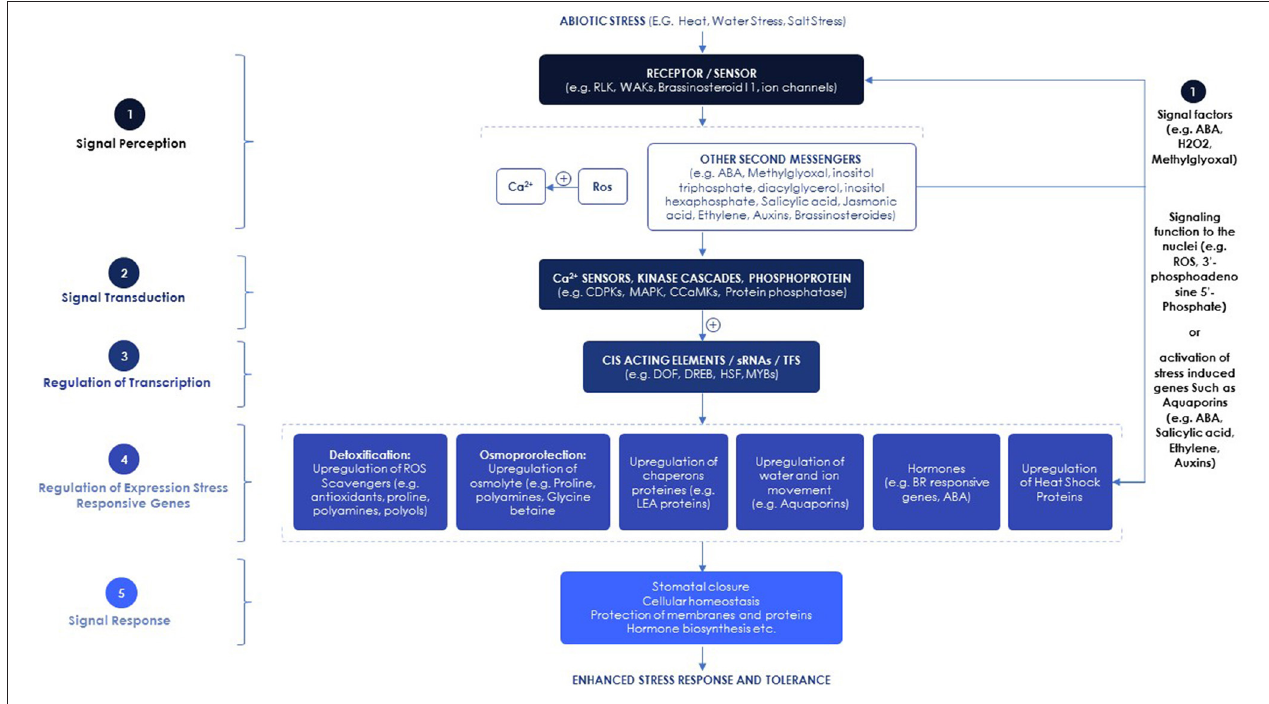
FIGURE 1 | Signaling pathways involved in plant abiotic stress